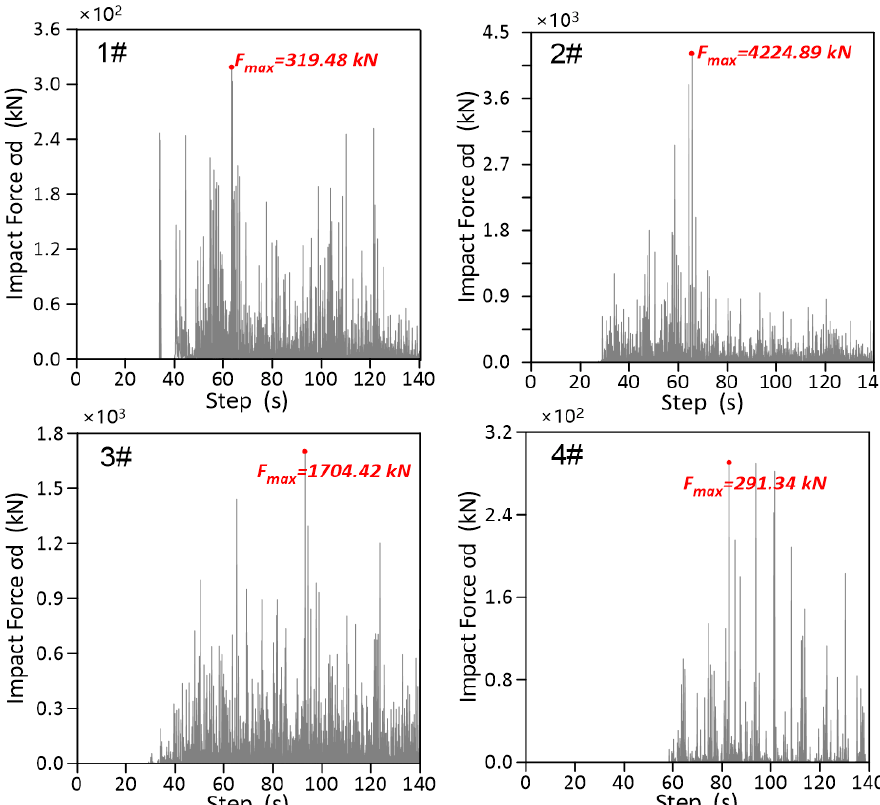
Figure 14. Analysis values of impact force at different monitoring buildings.